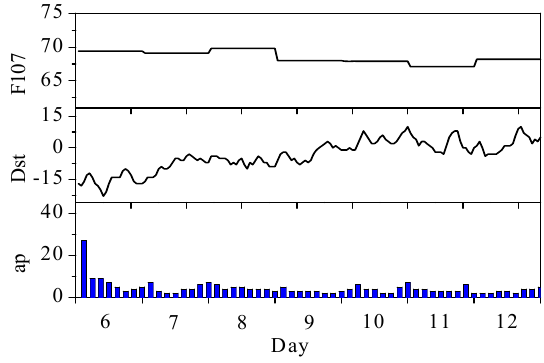
Fig.1. Variations of foF2 from May 6 to 12 over Chongqing station Fig. 1. Variations of fo F2 from 6 to 12 May over Chongqing station.